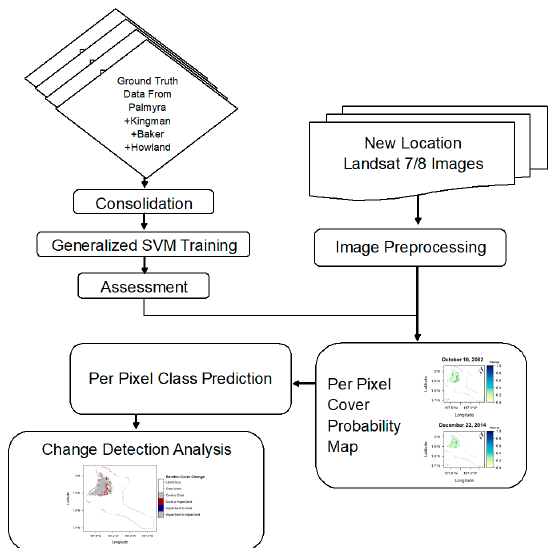
Figure 3. Robust SVM Classifier training and change analysis process flow for Tabuaeran Island and Kiritimati Island.